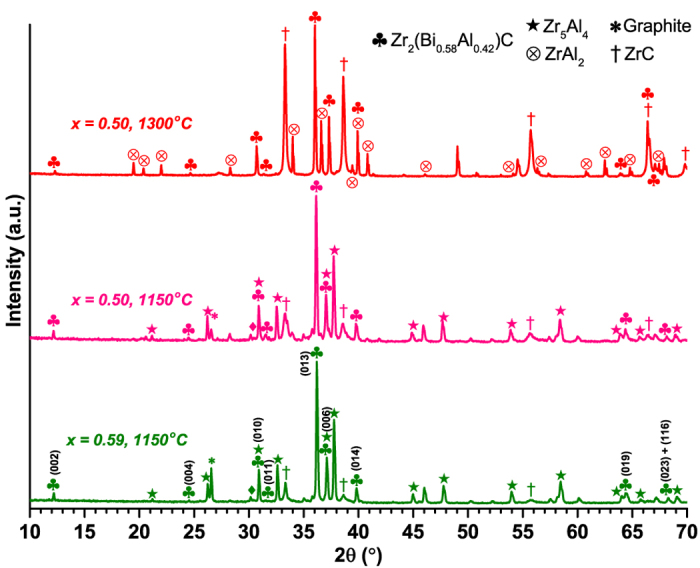
X-ray diffractograms of ZrH2 + Bi + Al + C powder mixes reacted for 10 h at 1300 or 1150 °C for Bi/(Al + Bi) ratios of 0.50 and 0.59.